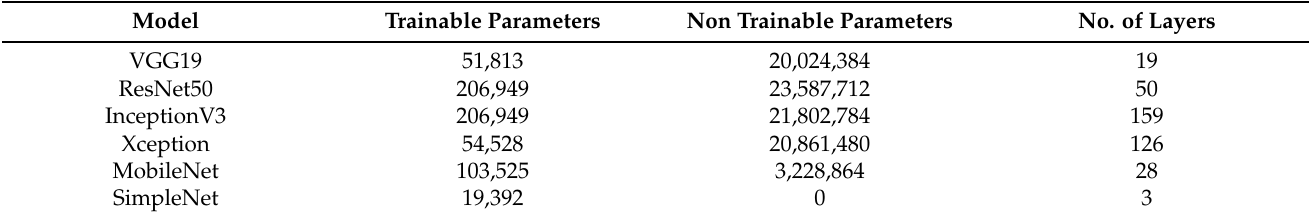
Table 1. Comparison of state-of-the-art models in terms of parameters and depths.